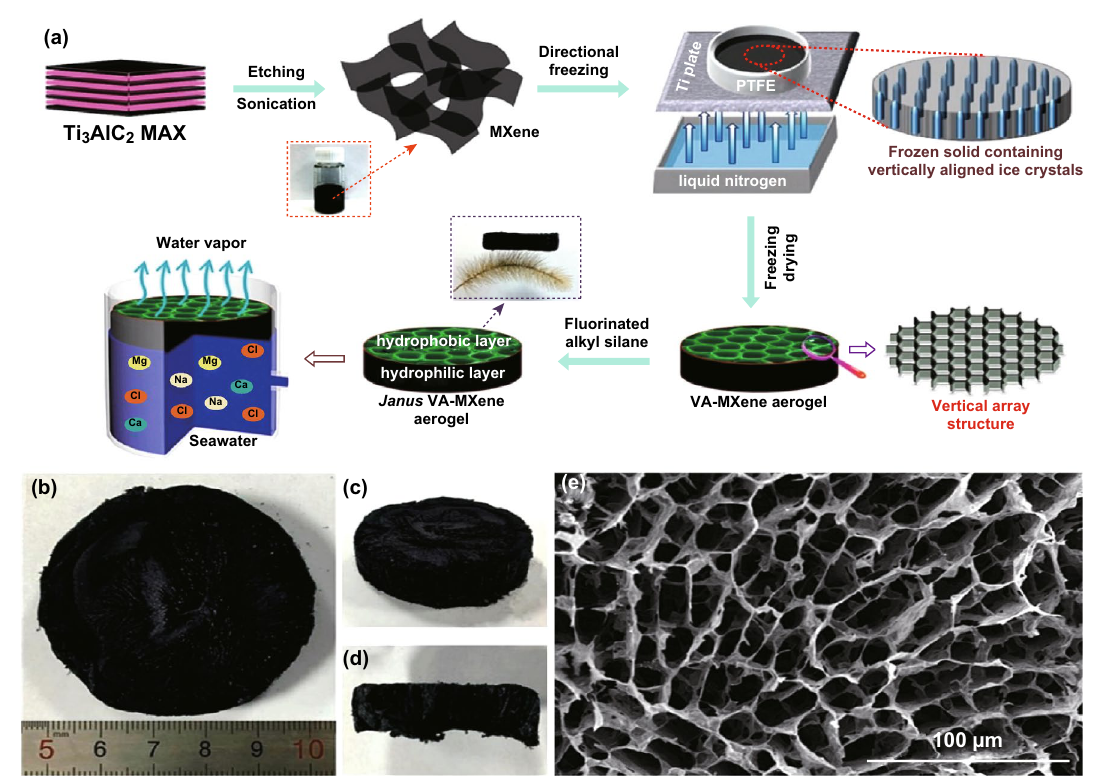
Fig. 15 a Fabrication process of a Janus VA-MXA with vertically aligned channels. b Digital photograph of the top view of the as-prepared Janus VA-MXA. c Photograph of the side view. d Photograph of the fracture face. e SEM images of the upper layer of prepared Janus VA-MXA. Reprinted with permission from Ref. [74]. Copyright © (2019) American Chemical